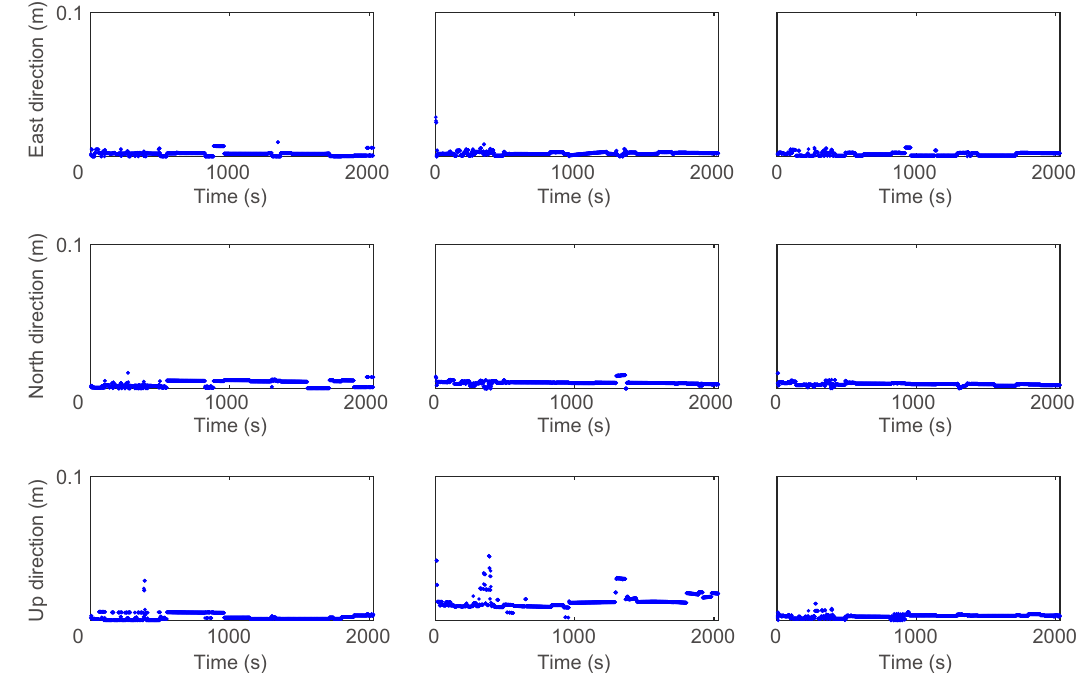
Fig. 12 Variations in the protection levels of the second kinematic dataset for PPP-WAR model with regional atmospheric corrections (left), PPP-AR model (middle), and PPP-RTK model (right) after considering the small probability of incorrect ambiguity fixing (with 1 × 10 − 7